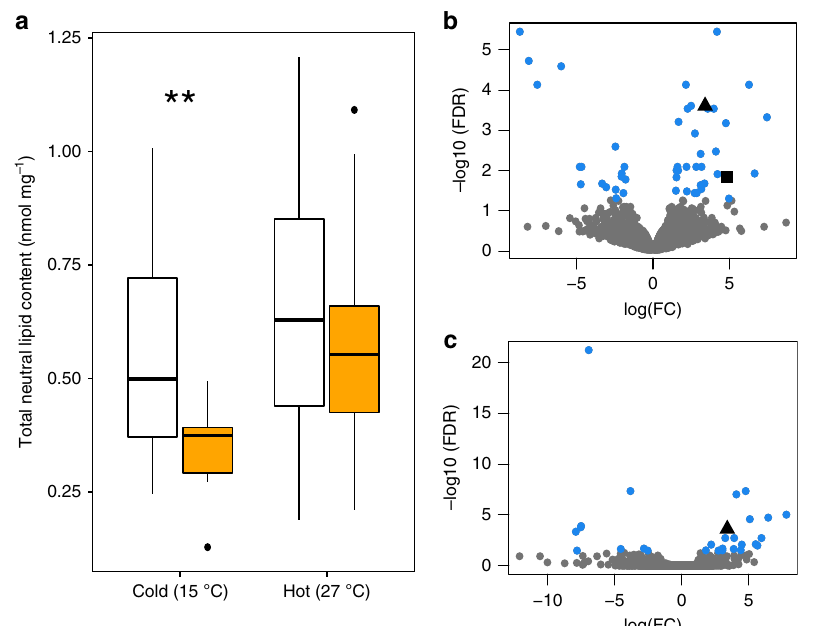
Fig. 4 Physiological differences between female morphs of C. crocea . a The mass corrected total neutral lipid content within abdomens for female morphs in two temperature treatments. White boxes are Alba females, while orange boxes are orange females. Alba females, on average, have larger neutral lipid stores in their abdomens than orange females. However there is an interaction between morph and temperature as the difference is only signi fi cant in the cold treatment (cold: t 29.12 = 3.42, P = 0.002, n = 32 abdomens hot: n = 25 abdomens, t 22.71 = 0.67, P = 0.51). Boxplot center line, median; box limits, 25th and 75th percentiles; whiskers, 1.5× interquartile range from the hinge; points, outliers. b Volcano plot to visualize gene expression differences between female morphs in pupal abdominal tissue. Each point is a gene. Genes not signi fi cantly differentially expressed between morphs are grey, while differentially expressed genes are blue. The black square is the triacylglycerol lipase and the black triangle is RIM . The X -axis is the log of the fold change (FC), positive log(FC) indicates the gene is upregulated in Alba individuals. c Volcano plot to visualize gene expression differences between female morphs in pupal wing tissue. Color coding, shapes, and axes are the same as in panel B. Source data are provided as a Source Data fi